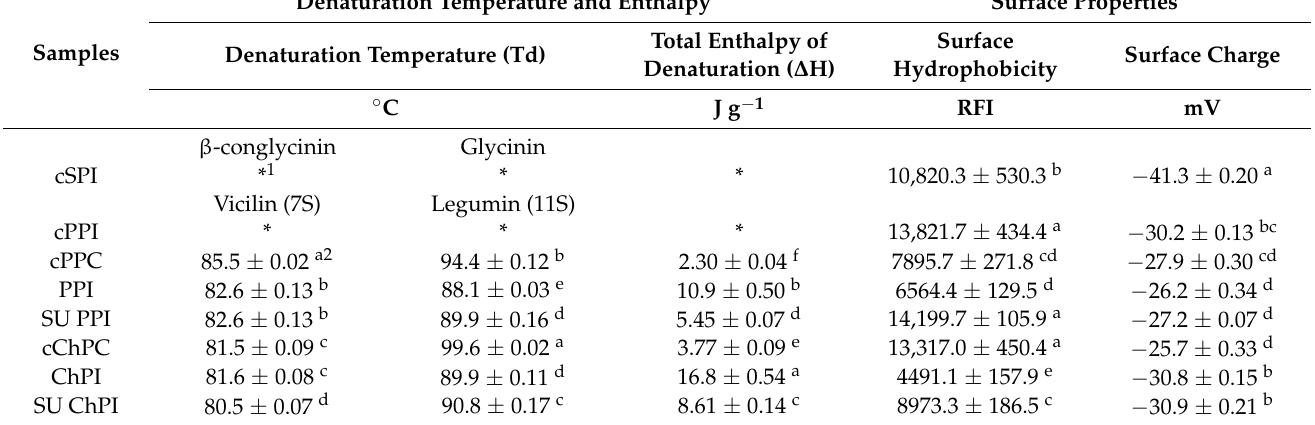
Table 2. Denaturation temperature and enthalpy, surface hydrophobicity, and surface charge of benchtop and scaled-up pea and chickpea protein isolates (PPI, SU PPI, ChPI, and SU ChPI), as well as commercial SPI, PPI, PPC, and